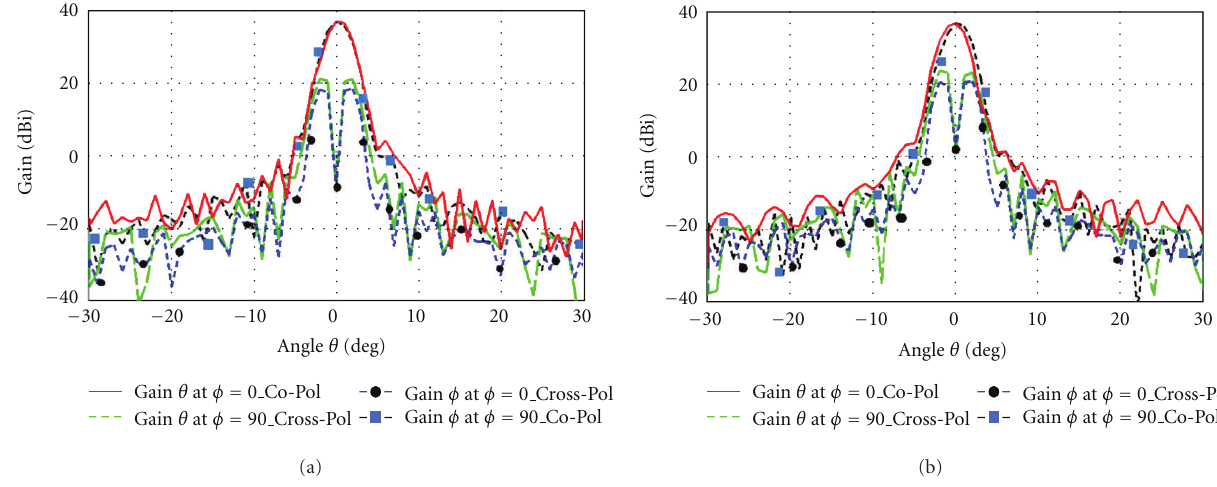
Figure 10: Reflector antenna radiation patterns at 7.73GHz with the feedhorn mode combination of TE 11 (40%) + TM 01 (30%) + TE 21 (30%) for the fixed phase values of (a) +90 ◦ and (b) − 90 ◦